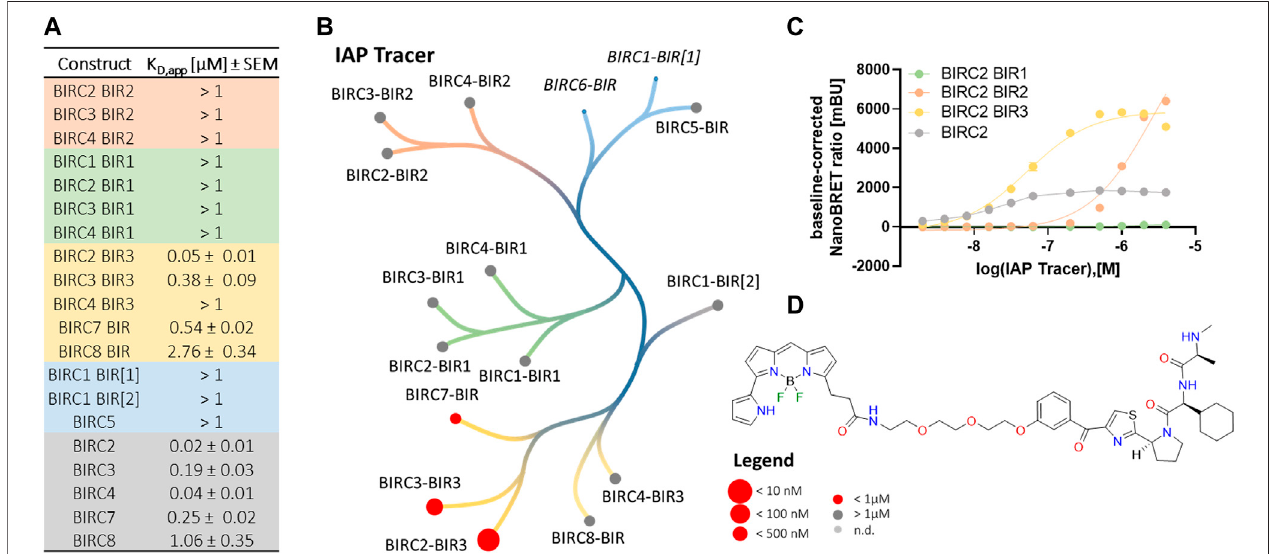
FIGURE 3 | NanoBRET tracer titrations of the different BIRC constructs. (A) Determination of the binding af fi nities of the tracers to the different BIRC constructs. Datawere expressed asmean ±SEM using two independentexperiments performed induplicates ( n = 4). (B) Tracer potency across theBIRCfamily. Here,BIRC6was not tested and the BIRC1-BIR1 domain did not show a signi fi cant luciferase signal and therefore, both constructs were excluded (italic). (C) Tracer titration curves for BIRC2 full-length proteins and its corresponding BIR domains ( n = 4). (D) Structure of the NanoBRET IAP tracer.